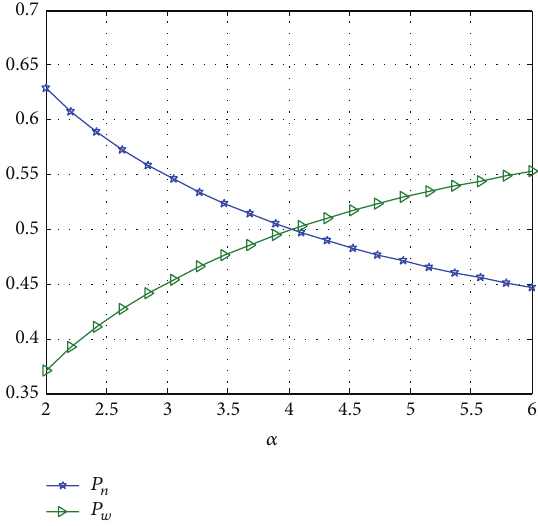
Figure 5: The probability of server’s state with the change of 𝜂 .